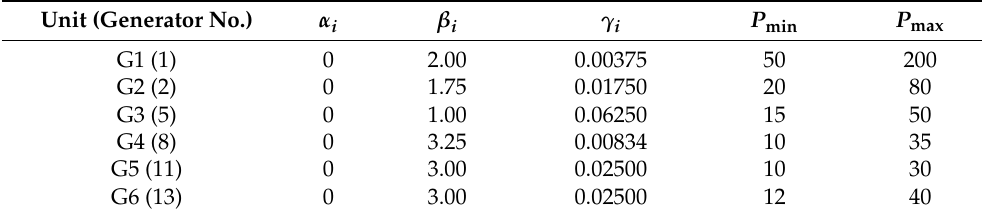
Table 7. Parameters of power generations in the IEEE 30-bus. Unit (Generator